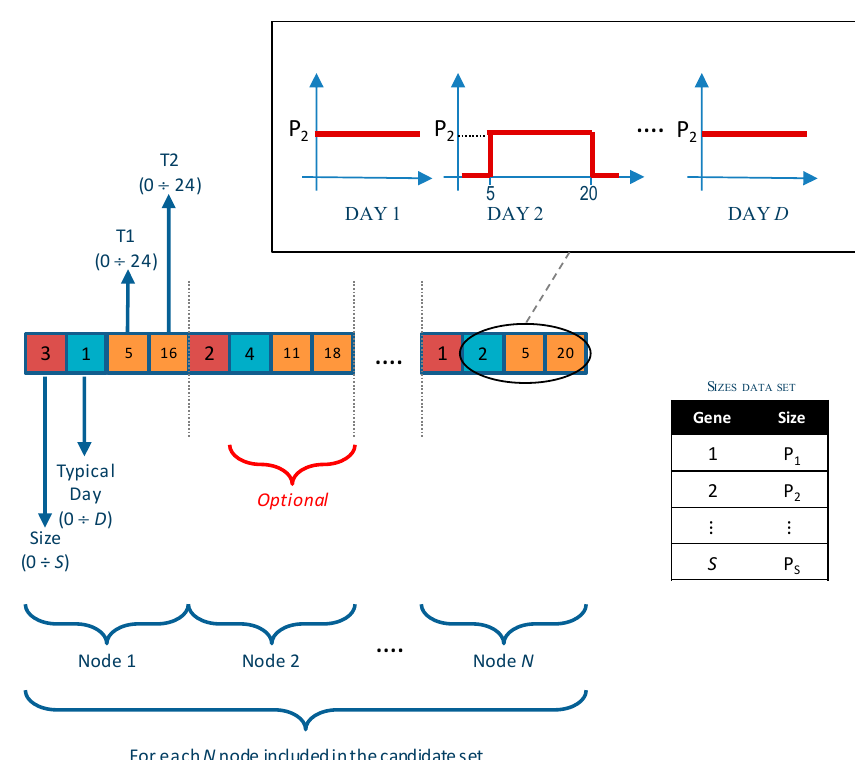
Figure 2. Optimal placement of capacitor banks based on GA: solution coding.